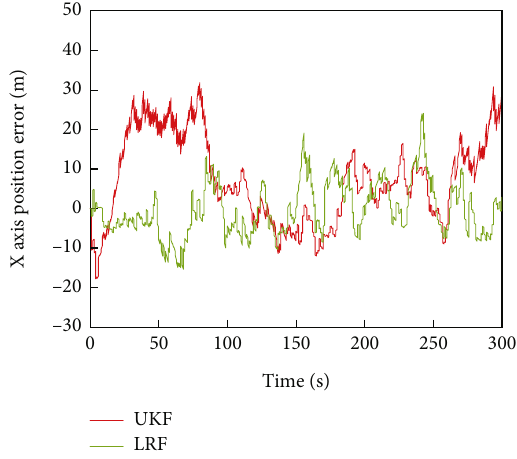
Figure 9: X -axis position error contrast curves.